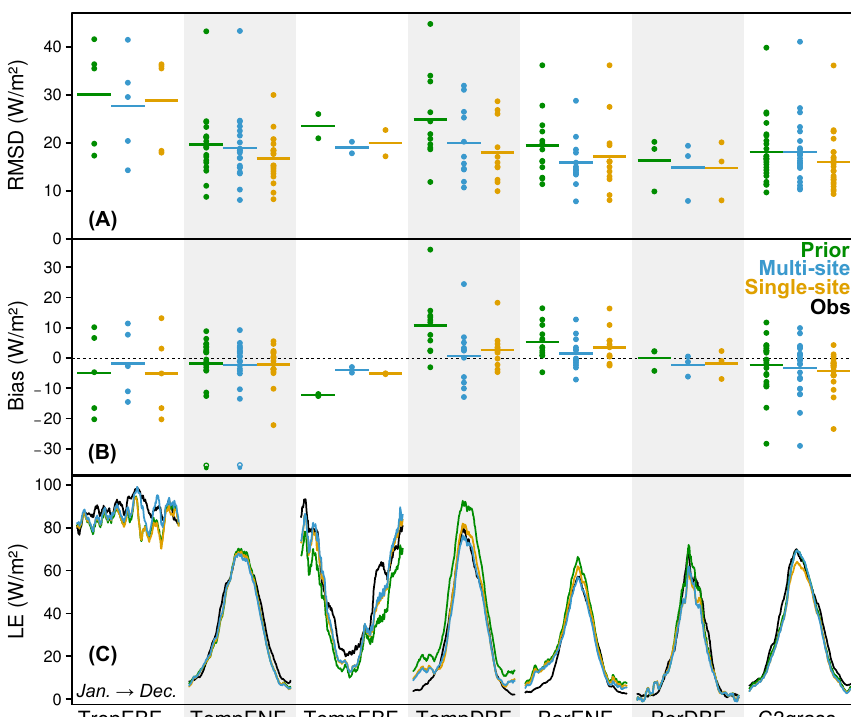
Figure 2. Model–data (a) RMSD and (b) bias for the daily LE time series at each site (filled circles), grouped and averaged by PFT (horizontal bars), in three cases: prior model (green), multisite optimization (blue) and single-site optimization (orange). (c) PFT-averaged mean seasonal cycle of LE, for the training observations (black) and the three aforementioned cases, smoothed with a 15-day moving-average window.